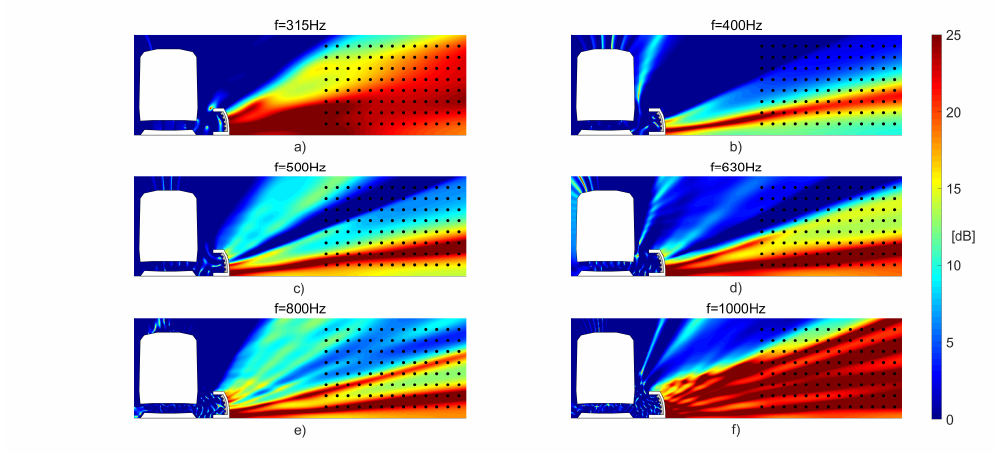
Figure 20. Insertion loss maps for the curved noise barrier with absorptive layer for frequencies 315 Hz, 400 Hz, 500 Hz, 630 Hz, 800 Hz and 1000 Hz ( a – f ), with the presence of the receivers (black dots) used to calculate mean IL (Figure 18).